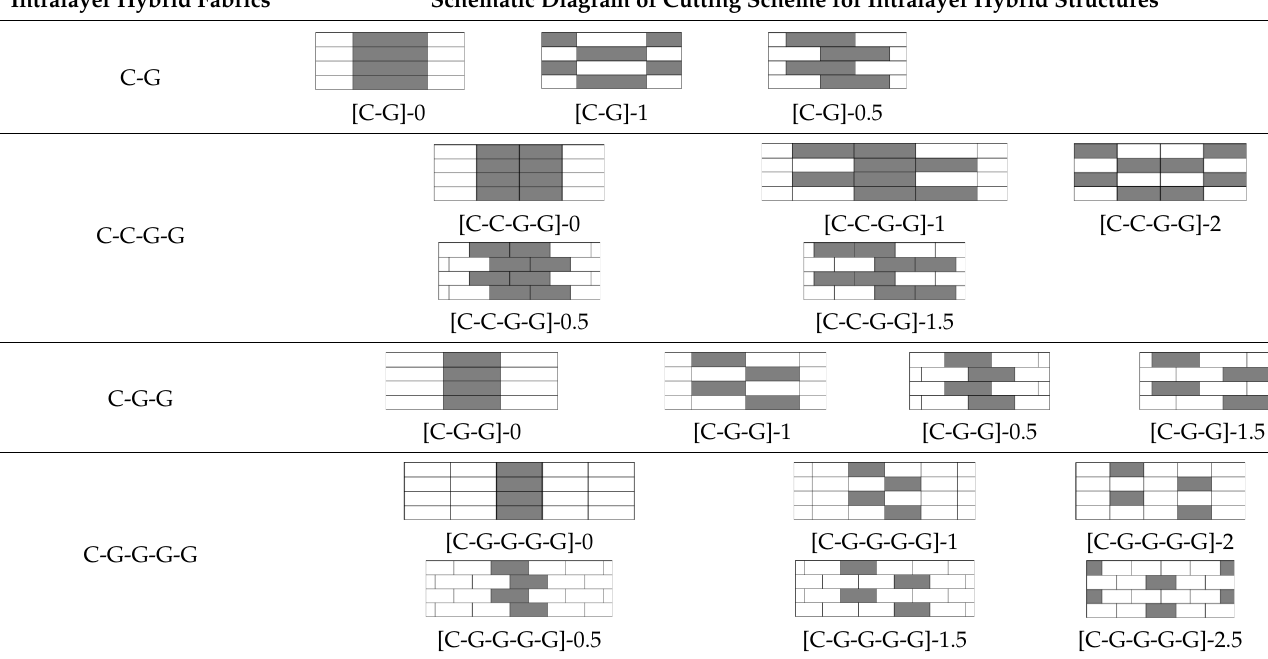
Table 8. Schematic diagram of cutting scheme for intralayer hybrid composites with various hybrid ratios and stacking structures. Schematic Diagram of Cutting Scheme for Intralayer Hybrid Structures